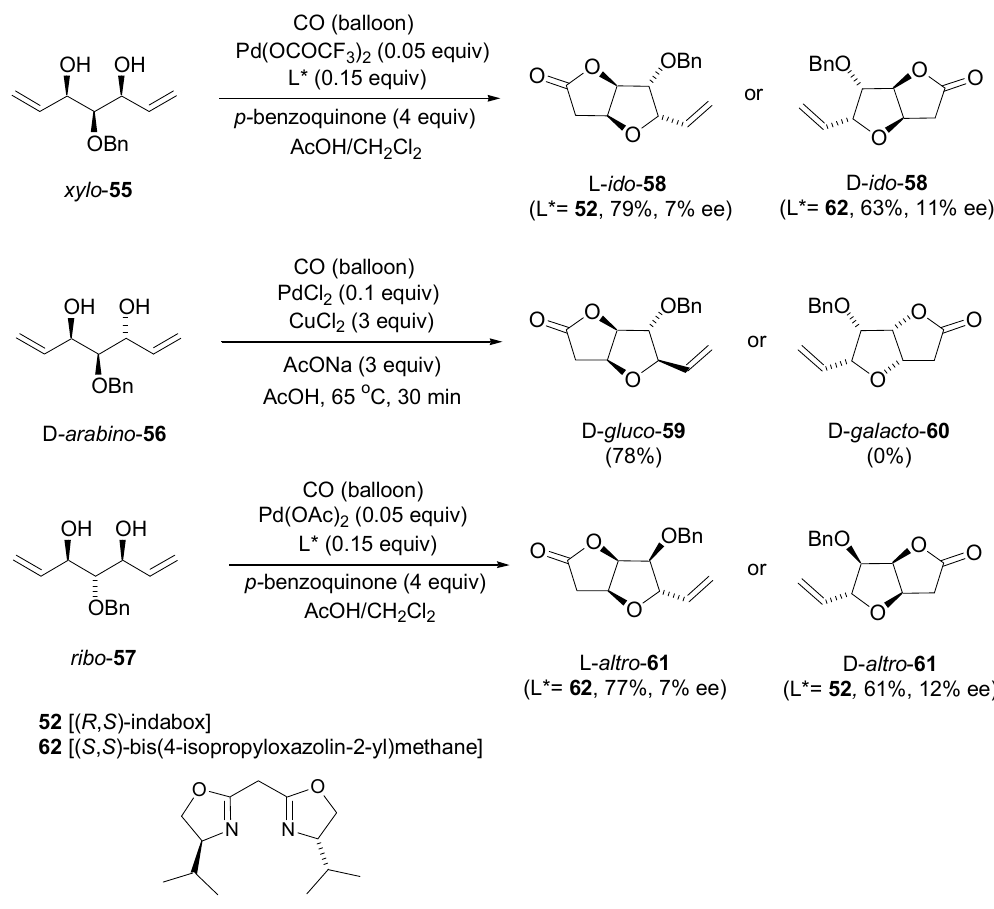
Scheme 24. Palladium(II)-catalysed oxycarbonylation of meso -diols 55 and 57 , and pseudo -C -symmetric enitol 56 . 2